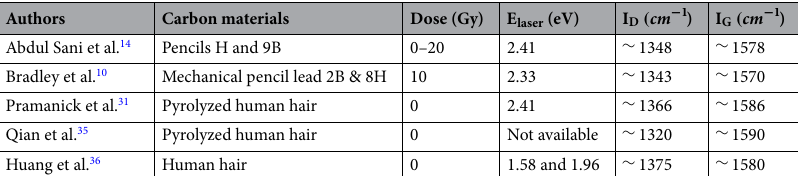
Table 2. Raman D and G peak intensity of carbon-based materials found by several research groups.